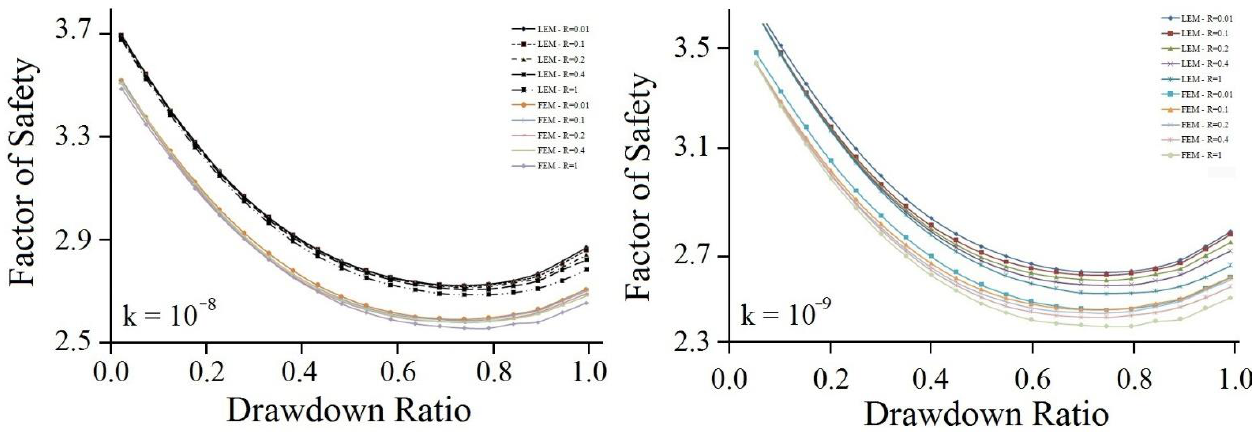
Figure 10. The F.S vs. drawdown ratio in deep sliding surface based on LEM/FEM models. 3.4. Real-Data Verifications In order to understand the capability and performance of stability and the charts pro- vided by the couple models, these models were verified by conducting a comparative analysis and justification of the ground information obtained from the extensive Alavian earth-fill dam body and lake to observe its behavior during the construction and service phases. Among these instrumentations, the vibrating-wire piezometers, mechanical pie- zometers, hydrogeological boreholes, and stand-pipe piezometers are used for measure- ment of the water level in the dam body and lake. A total water-level drawdown of about 25.45 m in 114 days was measured and applied to the models. This drawdown was im- posed at a different rate (with an average rate of 0.22 m/day) because of the modeling of the existing conditions. Details of changing water levels in the reservoir and the measured pore-water pressures are indicated in the set of figures prepared to analyze the case. Fig- ure 11 provides information about the locations of the instrumentations that were in- stalled to measure the pore-water pressure in the dam and reservoir. To estimate the rapid drawdown conditions, the model was verified by measured data in pure flow and hydro- static pore- pressure variations in the dam’s upstream shell and core. The pure flow de- fined in the coupled analysis systematically leads to lower water pressure than the uncou- pled (pure flow) approximation during the first stages of the dissipation. On the other hand, the classical hypothesis for the drawdown analysis is considered an undrained or pure flow. This is due to the effect of the initial state after drawdown, controlled by the change in stress. Since pressures dissipate faster the stiffer the soil, this situation changes after some time and the water pressure records may cross at a particular time, which de- pends on the position of the considered point in the slope. Note also that full steady-state